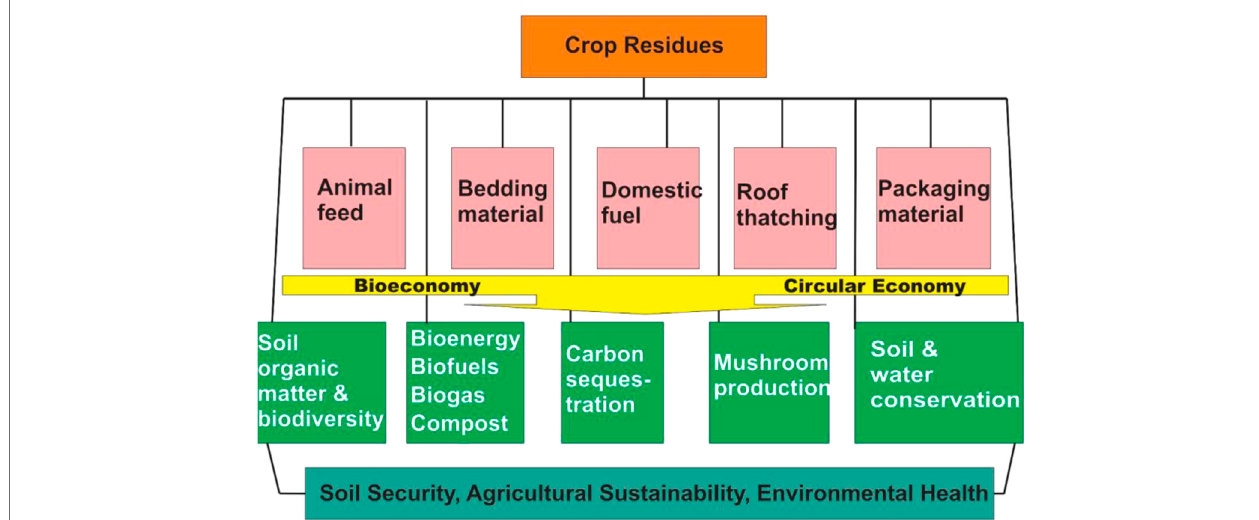
FIGURE 7 | Interventions in Crop Residue Management: Bioeconomy and circular economy perspectives.